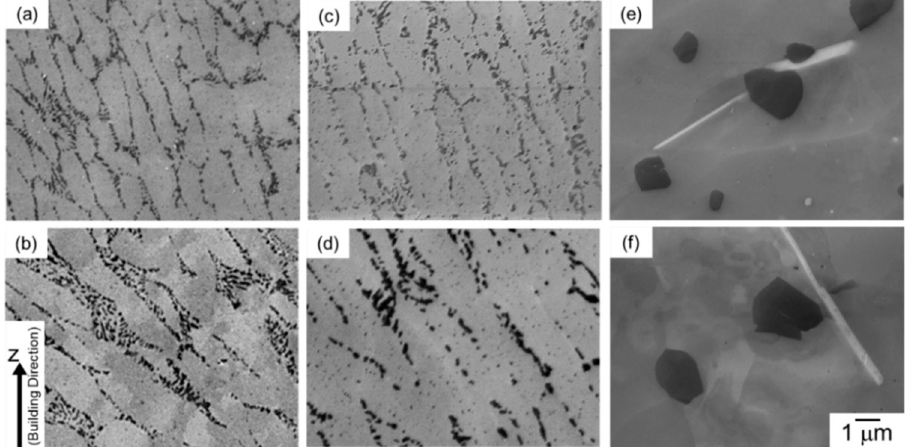
Figure 10. SEM micrographs of the microstructures taken from the strut portion of the lattice specimen with different vertical distances from the geometric center: ( a , c , e ) d S = 0.2 mm and ( b , d , f ) d S = − 0.3 mm; ( a , b ) as-manufactured, ( c , d ) annealed at 300 ° C for 2 h, and ( e , f ) solution heat treated at 530 ° C for 6 h.